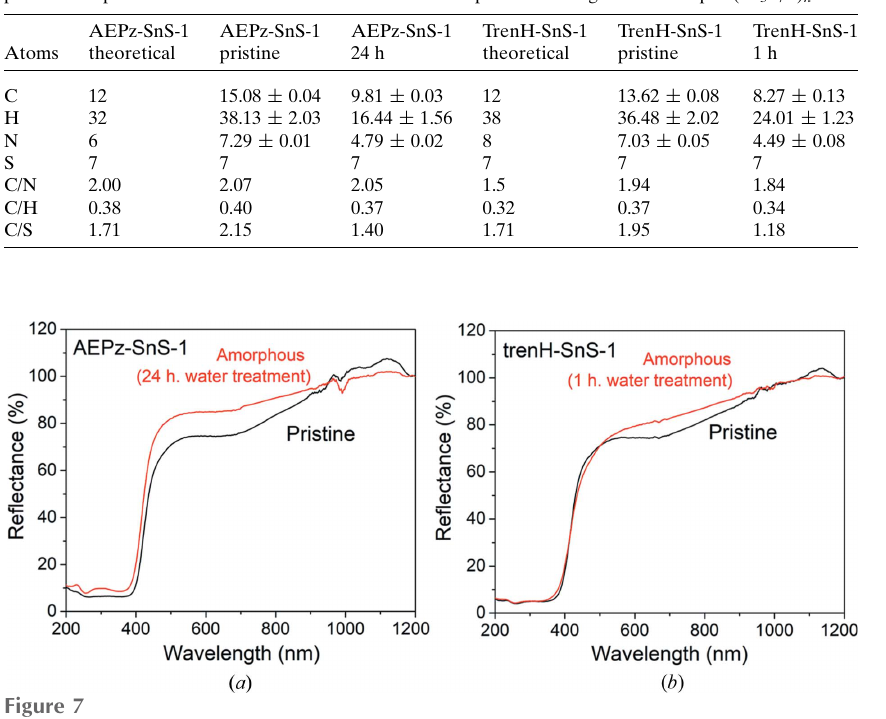
Table 2 Elemental analysis of AEPz-SnS-1 and trenH-SnS-1, both pristine and water-treated for 1 h. All atomic stoichiometries have been referenced to seven sulfur atoms. Expected values are based on a pristine sample with no contaminants and with two monoprotonated organic amines per (Sn 3 S 72 (cid:2) ) n .